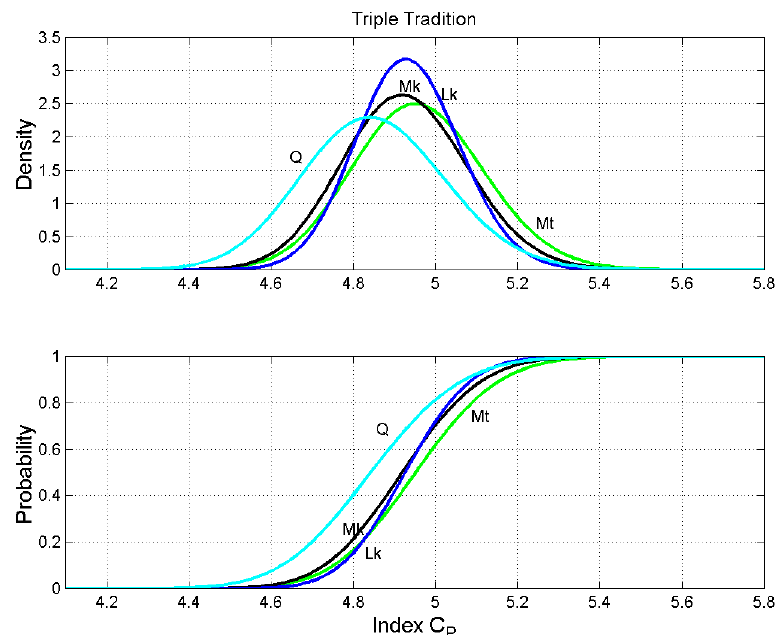
Figure 6. Triple Tradition and Q. Probability density functions (upper panel) and probability distribution functions (lower panel) of the number of words per sentence 𝐶 𝑃 . Matthew : green line; Mark: black line; Luke : blue line; Q : cyan line.